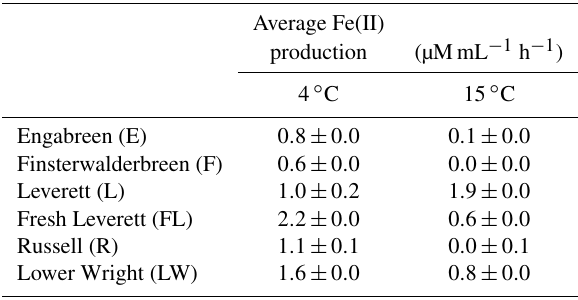
Table 2. Rates of microbial iron reduction in second-generation en- richment cultures. Data are expressed as average ± standard devi- ation Fe 2 + production (µM) permL of duplicated enrichment per